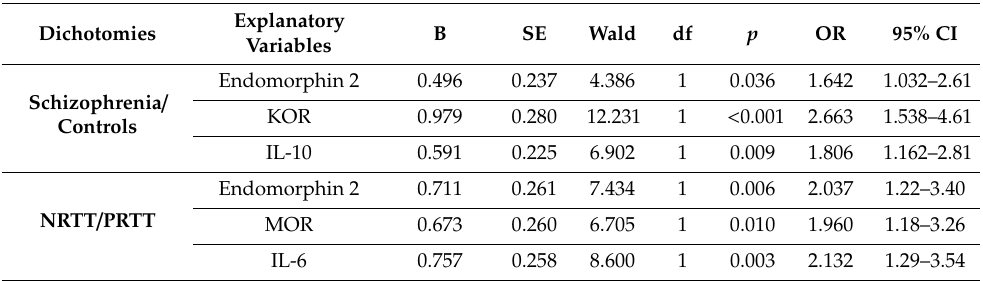
Table 5. Results of two di ff erent binary logistic regression analyses with schizophrenia (versus healthy controls) and non-responders to treatment (NRTT) versus partial responders to treatment (PRTT) as dependent variables and the biomarkers as explanatory